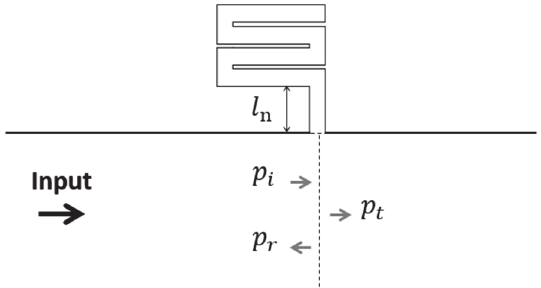
Figure 6. Deriving incident pressure and transmission pressure in the unit cell.